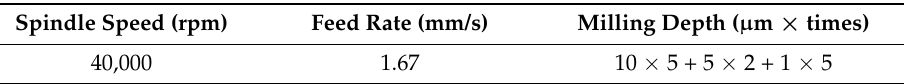
Table 4. Micromilling parameters.